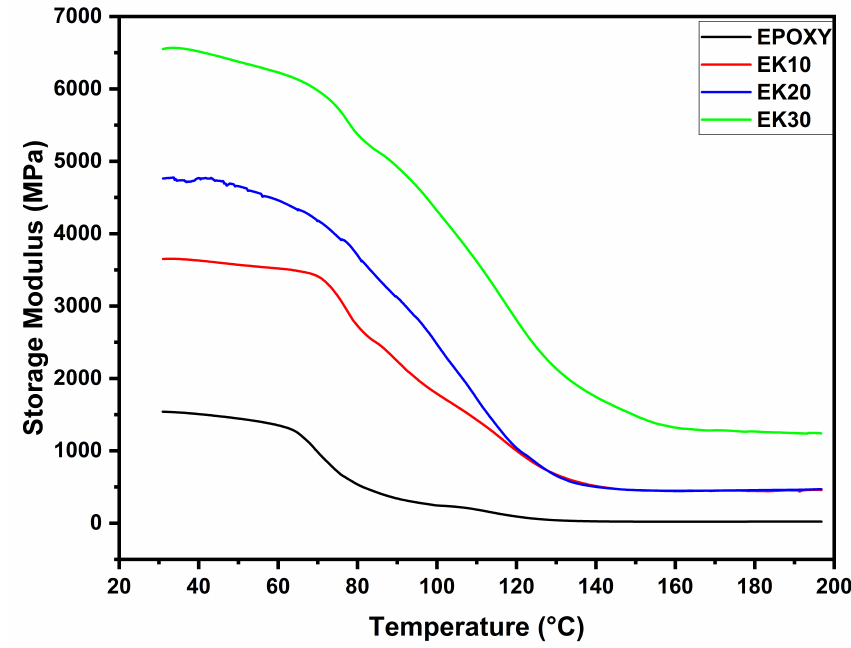
Figure 3. DMA storage modulus (E’) curves for epoxy composites incorporated with different amounts of kenaf fibers.